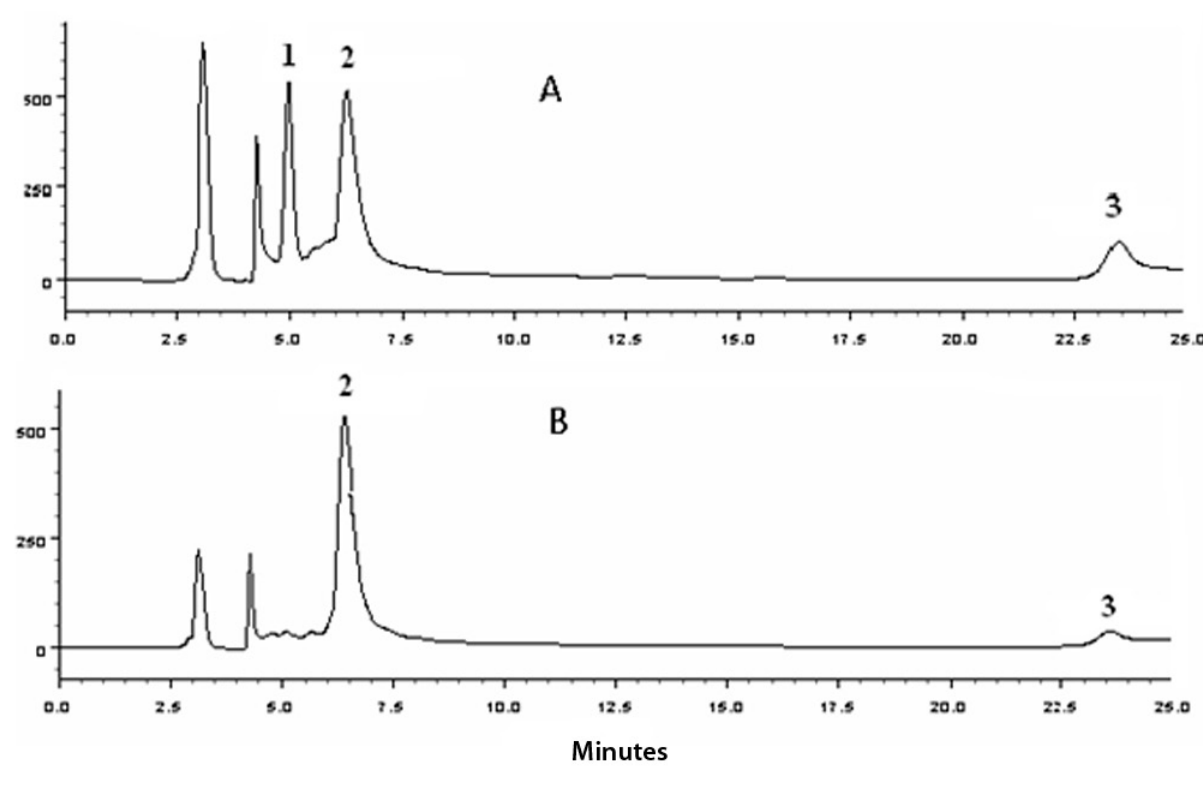
Figure 1. HPLC chromatograms of methanol extracts of ( A ) S. tuberosa , Hibar Lichrospher column 100RP18 4.6 mm x 25 cm, 5 mm; solvent mixture I:II [I: aqueous solution of H 350 nm and ( B ) S. mombin . Peaks: 1 – rutin, 2 – ellagic acid, and 3 –